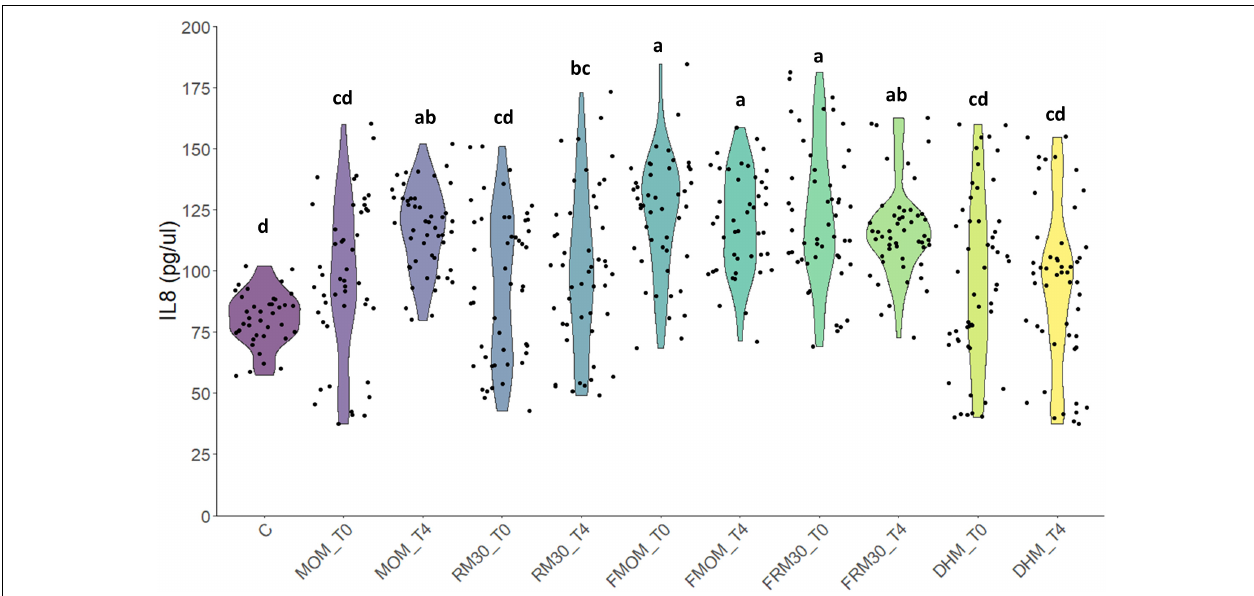
FIGURE 6 | Effect of milk restoration on stimulation of IL-8 secretion in Caco-2 epithelial cells. ELISA quantification of IL-8 secretion in Caco-2 epithelial cells after 24 h of treatment with the different milk supernatants (MOM, RM30, FMOM, FRM30, and DHM) at time 0 (T0) and 4 h (T4). Untreated Caco-2 cells were used as control (C). The experiment was performed with biological and technical triplicates. ANOVA and Tukey honestly significant difference method were used to assign statistical significance for a p <